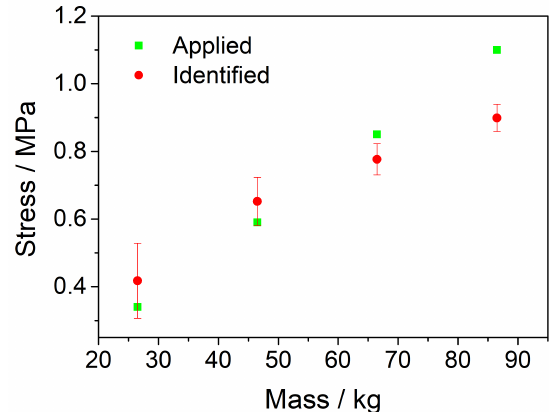
Figure 8. The average identified load results of moving load